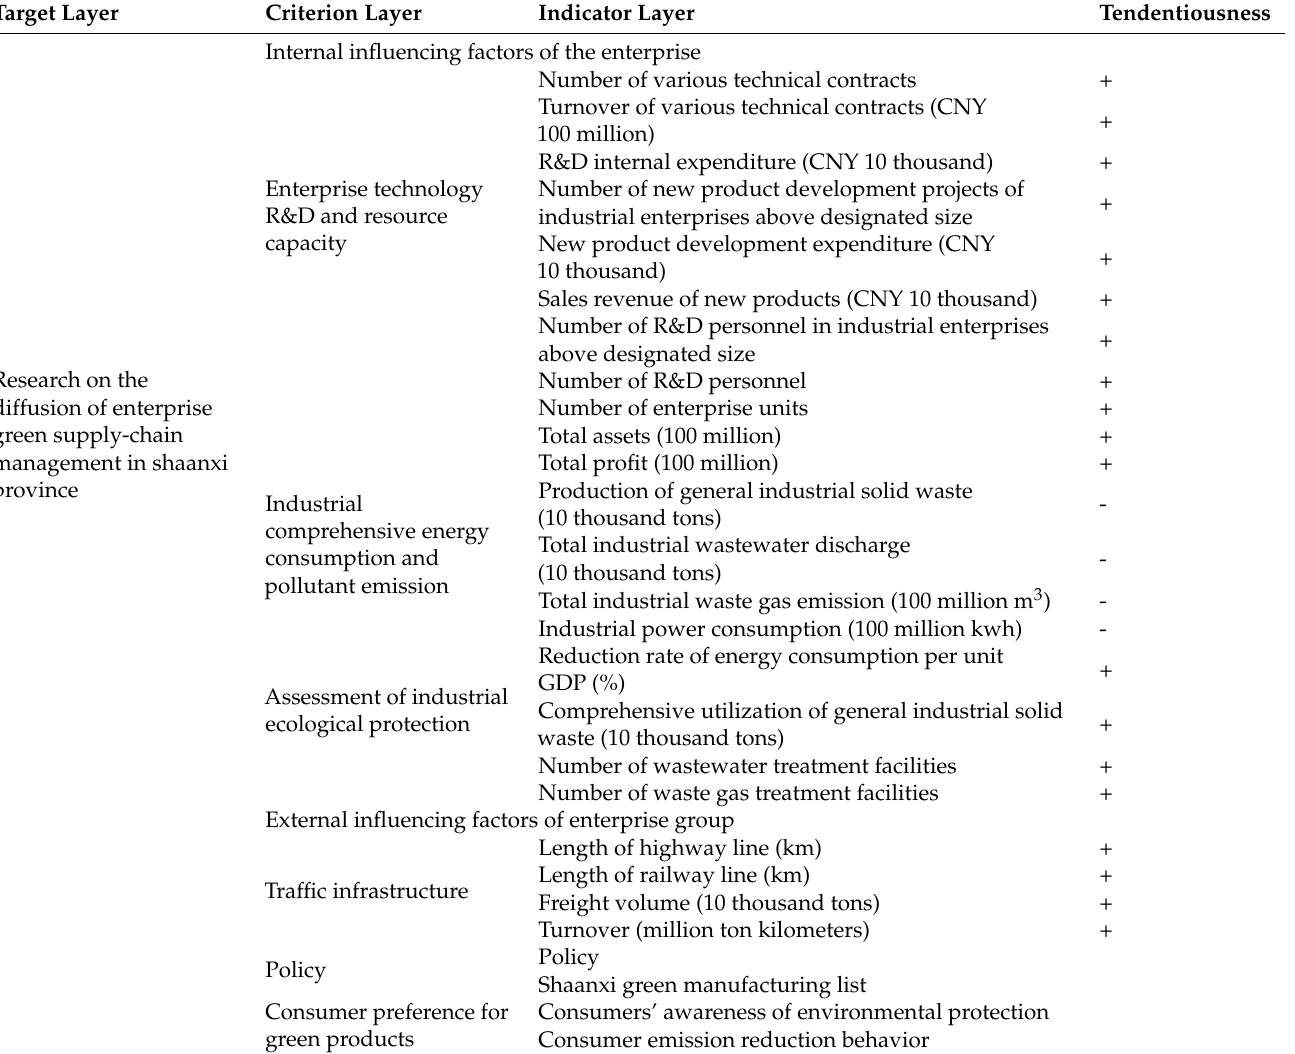
Table 3. Assessment indicators for the development status of green supply chain of Shaanxi enterprises.